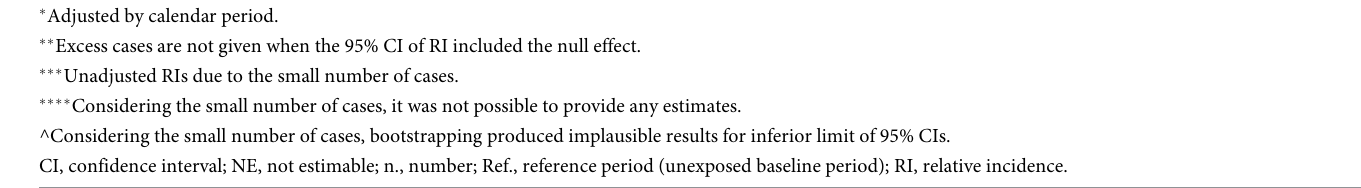
Table 3 and Fig 2 show the adjusted RIs (unadjusted estimates in S5 Table) and ECs by age, sex, and product in the 7 days risk period (S6–S15 Tables and S4 Fig). In males, the risk of myocarditis/pericarditis increased in the [0 to 7) days following a first dose of mRNA-1273 (RI = 12.28, 95% CI: 4.09 to 36.83) and following a second dose of